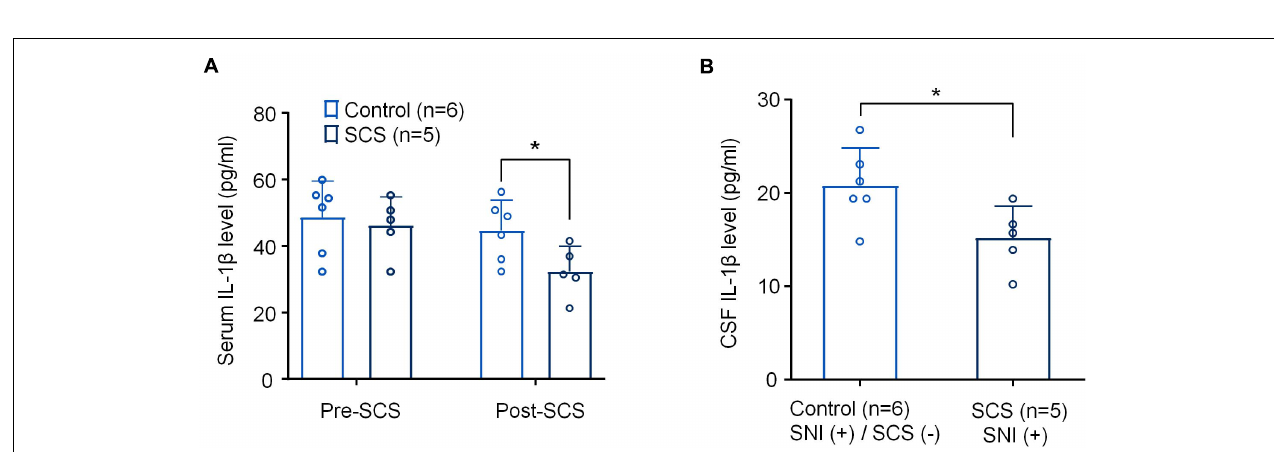
FIGURE 3 | SCS at 1 kHz reduces IL-1 β levels in serum and CSF samples from SNI rats. (A,B) Effects of 1 k Hz SCS (80% MoT) on IL-1 β levels in serum (A) and CSF (B) . * p < 0.05, One-way ANOVA, followed by Bonferroni post hoc test in A. * p < 0.05, two-tailed Student’s T -test (B) . The sample sizes (number of rats per group) are indicated in each panel. Control = SNI ( + )/SCS ( − ).